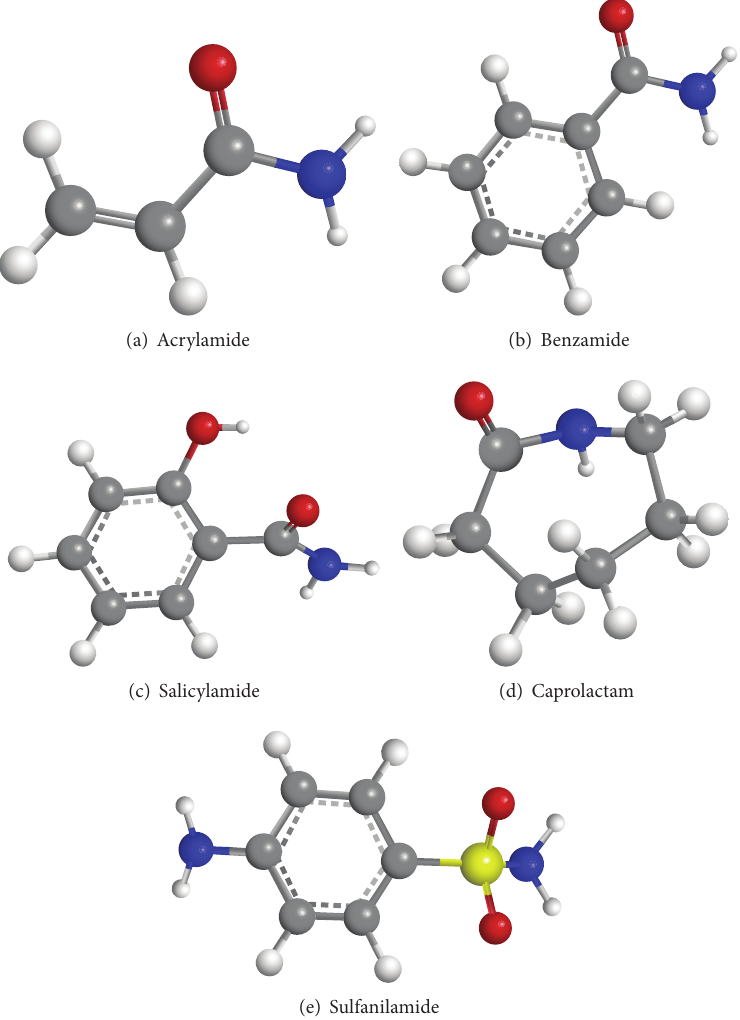
Figure 1: The molecular structures of acrylamide, benzamide, salicylamide, caprolactam, and sulfanilamide. (a) Acrylamide; (b) benzamide; (c) salicylamide; (d) caprolactam; (e)